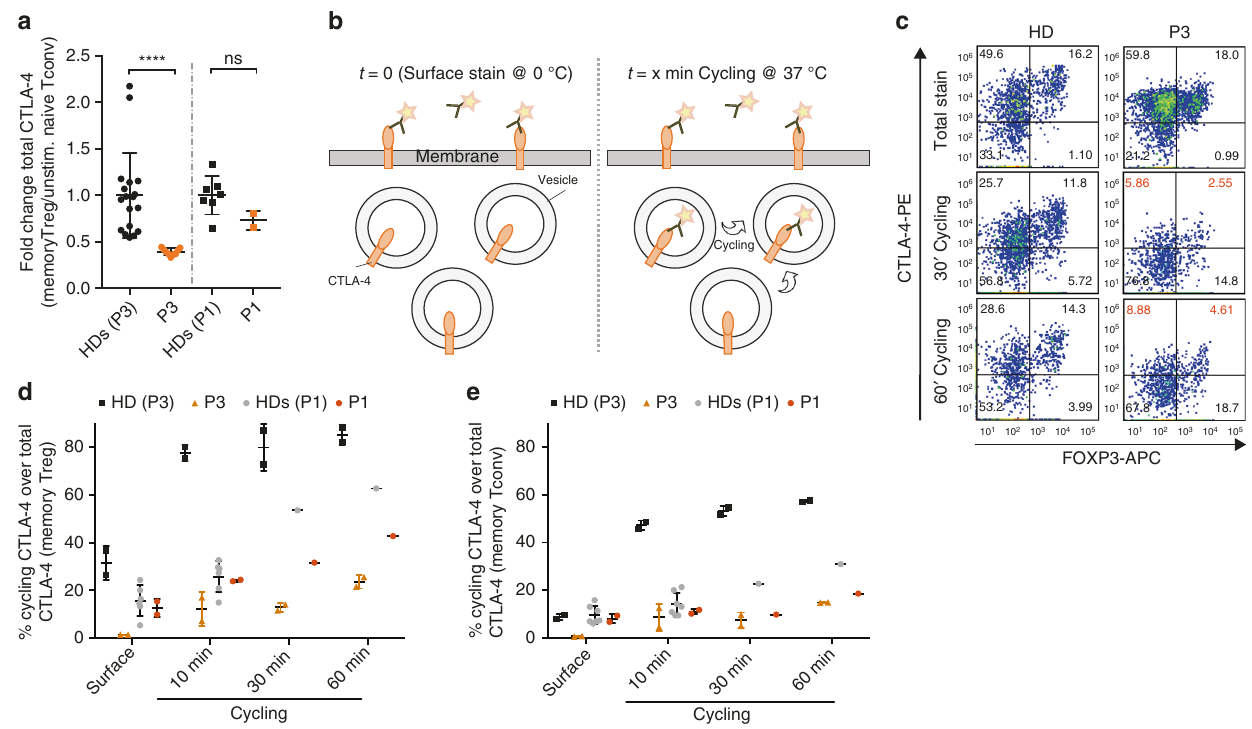
Fig. 3 DEF6 mutations affect CTLA-4 cycling. a Flow cytometric analysis of CTLA-4 expression in stimulated memory T regs (CD4 + CD45RA − FOXP3 + CD25 + ), compared to unstimulated naïve T conv as described in 37 . CTLA-4 expression in patients P1 and P3 was compared and normalized to respective healthy donor controls. Cells were stimulated for 16 h with anti-CD3/anti-CD28 antibody-coated beads. CTLA-4 expression after stimulation was reduced (P3) or unaltered (P1, n > 3). Data are overlaid with mean ± SD. Statistics: **** p < 0.0001, ns: p = 0.067 (Welch ’ s t test). b Schematic representation of CTLA-4 cycling assay performed on puri fi ed CD4 T cells. c – e CD4 T cells of P1 and P3 show reduced CTLA-4 cycling, compared to HD. Representative FACS traces of memory T cells of P3 ( c ) and time-course quanti fi cations of cycling traces of memory T reg ( d , CD4 + CD45RA − FOXP3 + ) and memory T conv cells ( e , CD4 + CD45RA − FOXP3 − ), normalized to respective total CTLA-4 expression of P1, P3 or HDs. Puri fi ed CD4 T cells were stimulated with anti-CD3/anti- CD28 antibody-coated beads for 16 h. Total stain was performed with standard intracellular staining. Cycling staining was performed by adding the labeled antibody before the cell harvest and incubation at 37 °C for the indicated times. Gating as in Fig. S3d. Representative of two independent blood shipments. Data are overlaid with mean ± SD. Source data of Fig. 3 are provided as a Supplementary Source Data fi